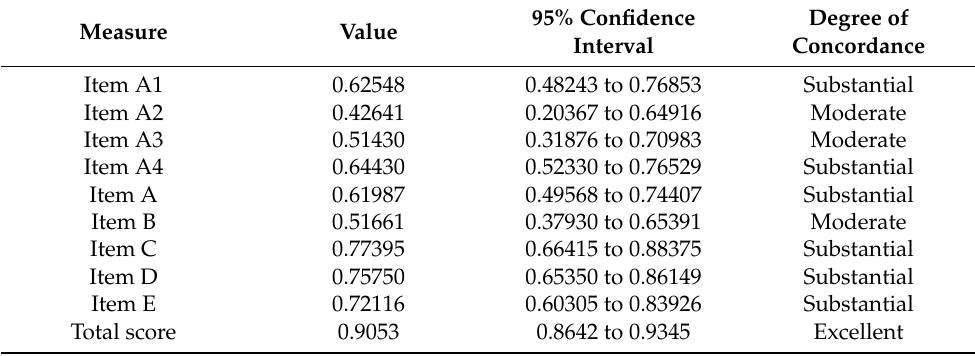
Table 2. Inter-rater concordance of the Helkimo items and the total